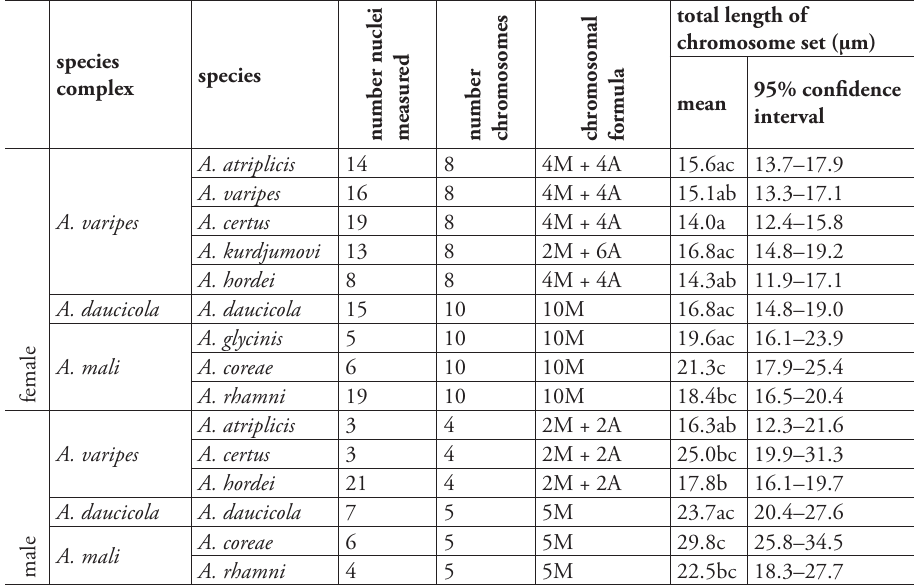
Table 3. Karyotypic features of nine Aphelinus species. Shared letters after means indicate that they do not differ significantly within each sex.